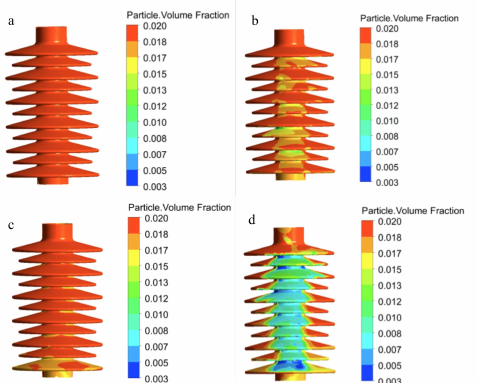
Figure 25. Distribution map of contamination on various sides of the insulator. ( a ) the contamination distributions on the windward side of 1# insulator; ( b ) the contamination distributions on the leeward side of 1# insulator; ( c ) the contamination distributions on the windward side of 2# insulator; ( d ) the contamination distributions on the leeward side of 2# insulator.